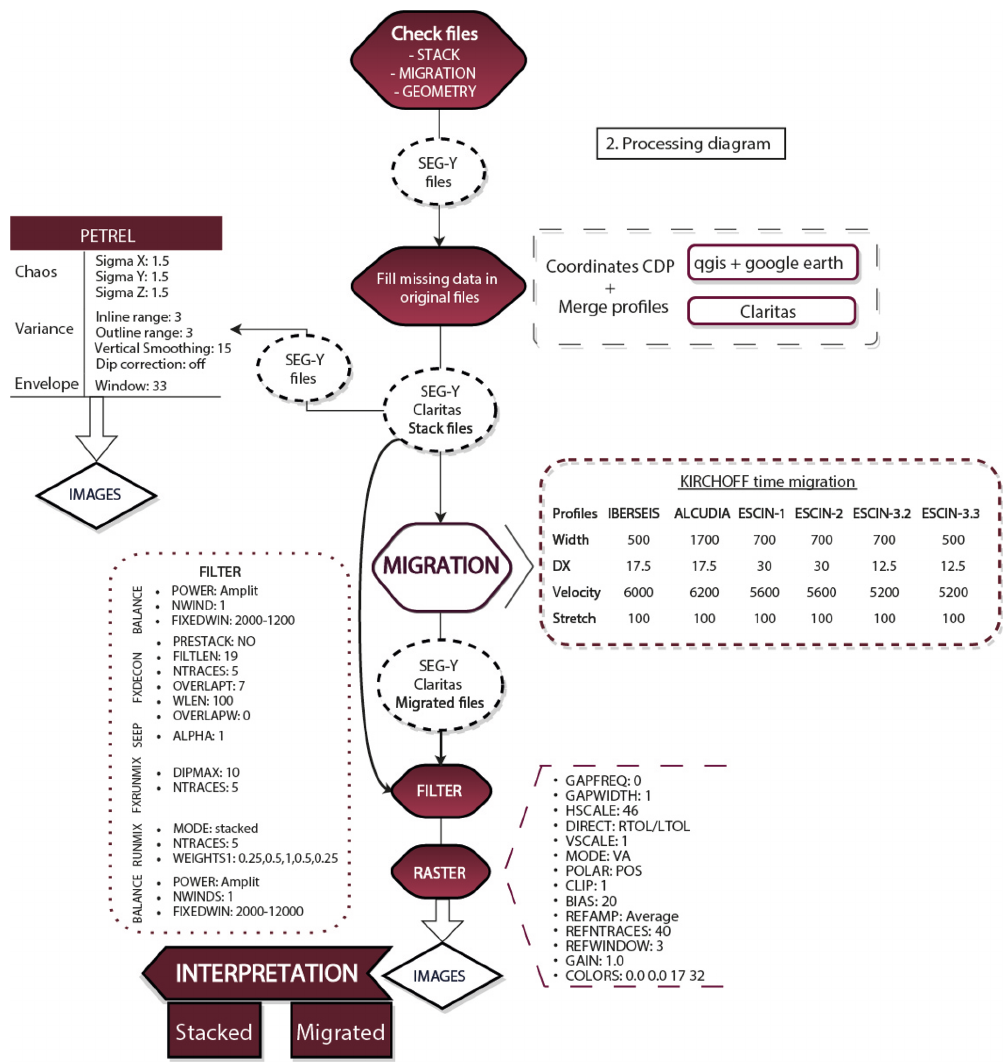
Figure 2. Processing flow carried over the SEG-Y original stack sections. This task was geared to improve and homogenize the resolution of the seismic images while creating new migrated sections. See Martínez García (2019) for further